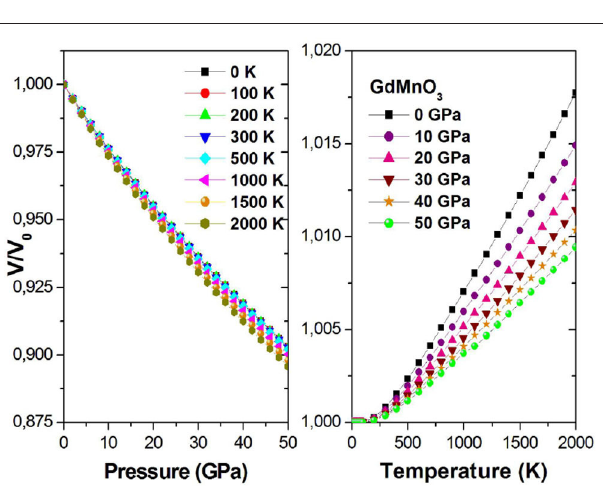
crossing points. The carrier concentration, can be adjusted by use of a gate voltage (Thelander et al.,